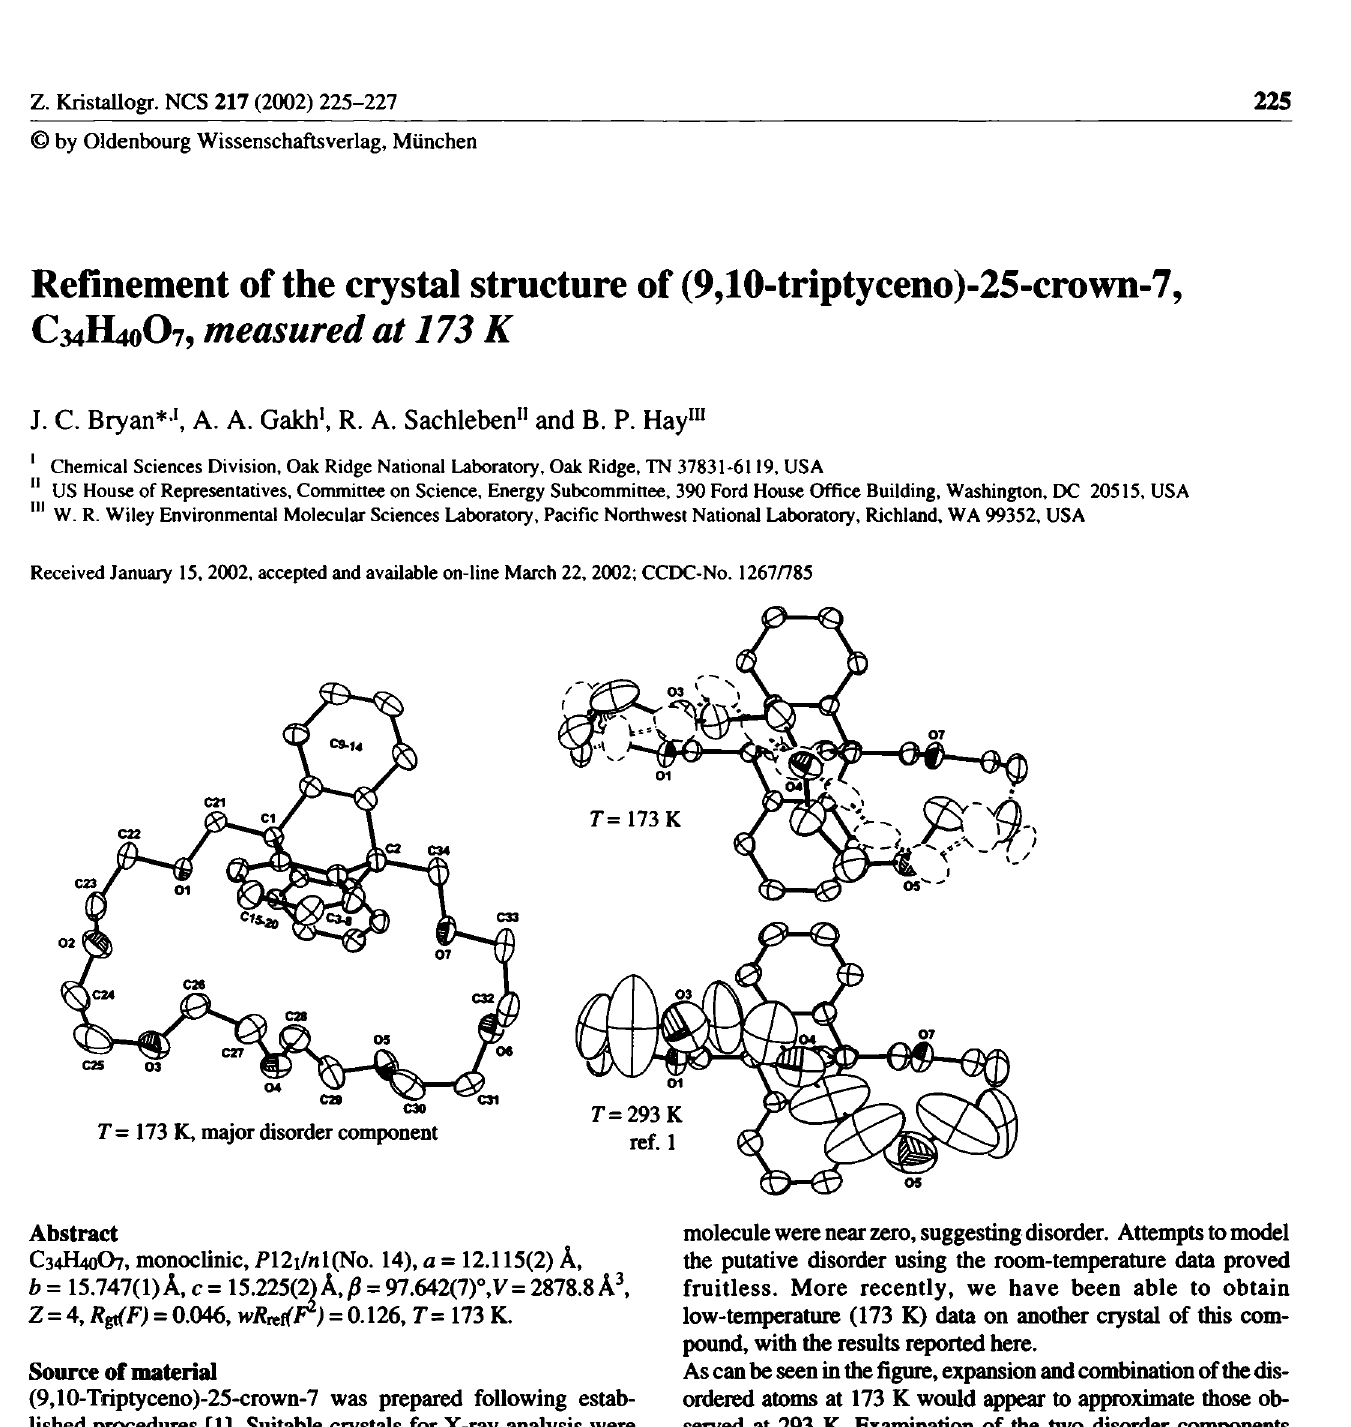
Table 1. Data collection and handling.